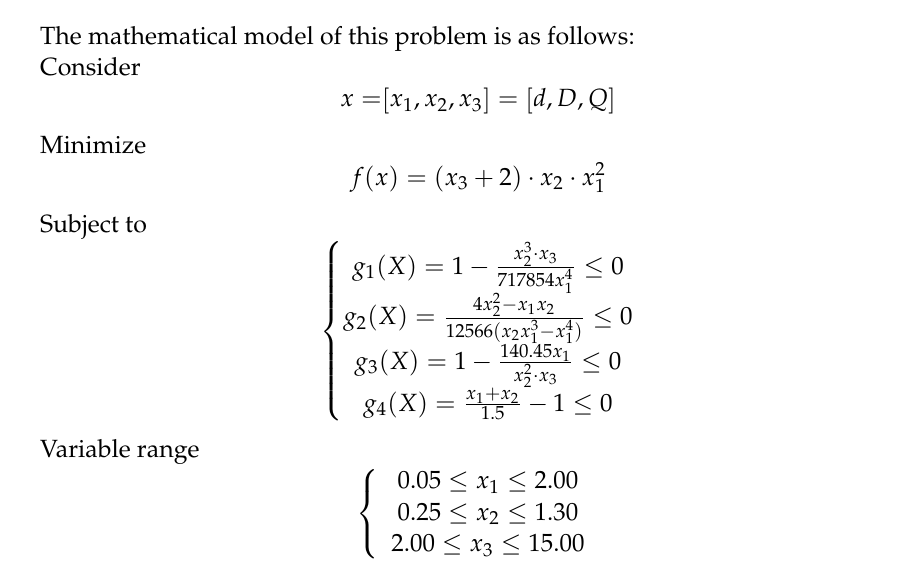
Figure 7. Schematic diagram of a tension/compression spring. ( a ) Schematic of the spring, ( b ) stress distribution evaluated at the optimum